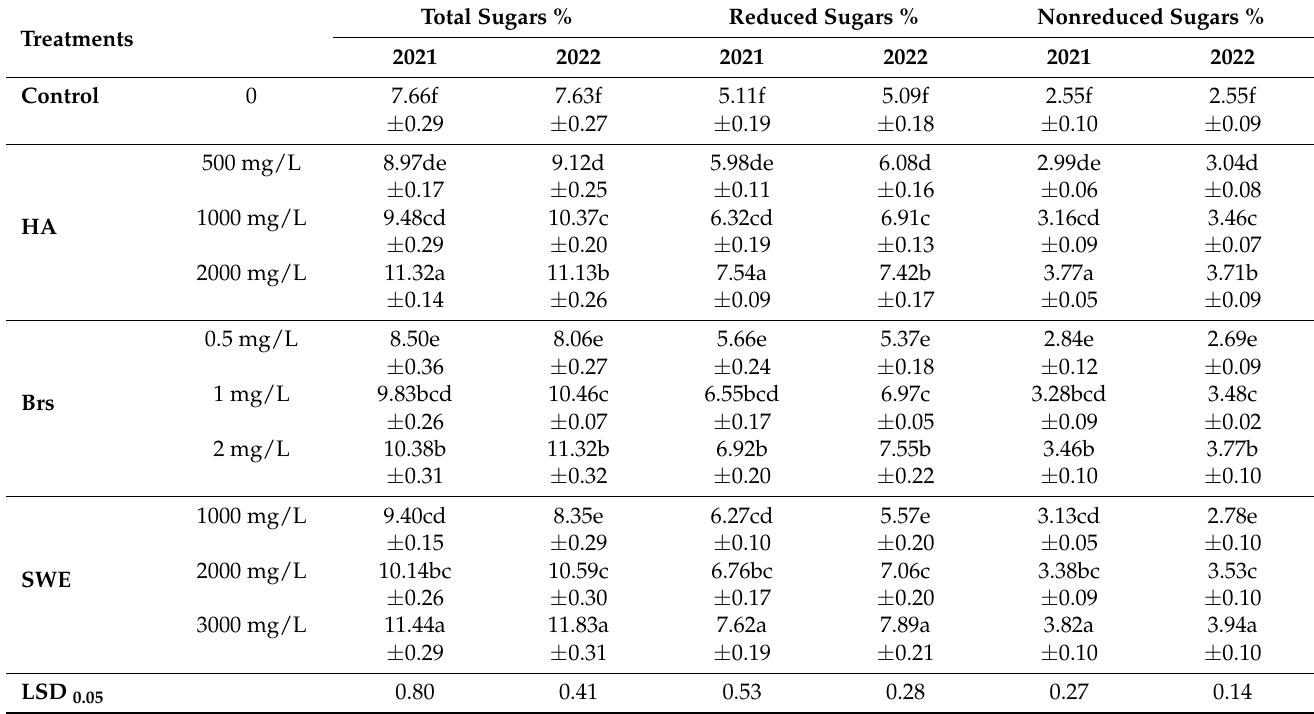
Table 8. Effect of foliar spraying of HA, Brs, and SWE on the fruit content of the total, reduced, and nonreduced sugars of apricot cv. Canino during